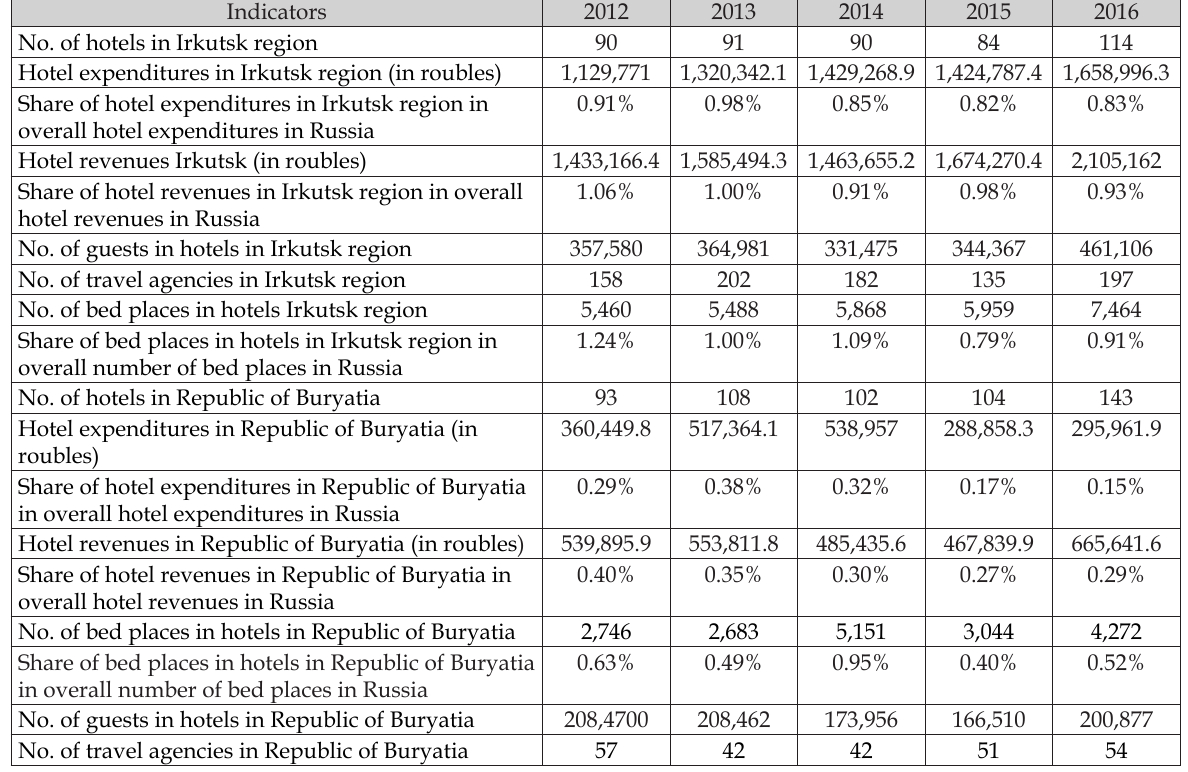
Table 4. Analysis of selected tourism indicators in lake